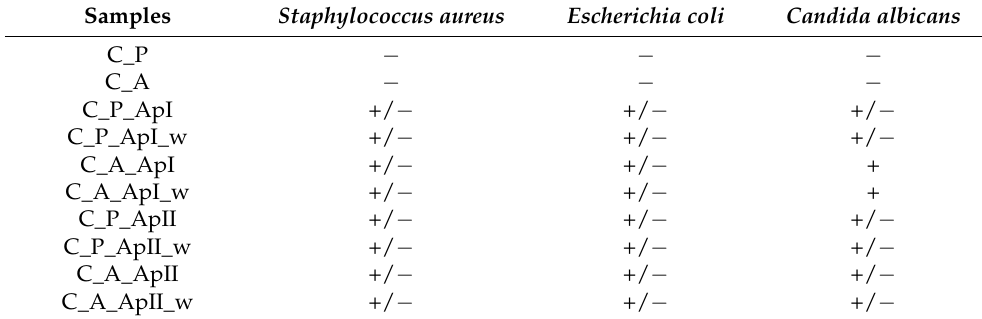
Table 6. Results of antimicrobial activity for an untreated and treated sample before and after care cycles. Samples Staphylococcus aureus Escherichia coli Candida